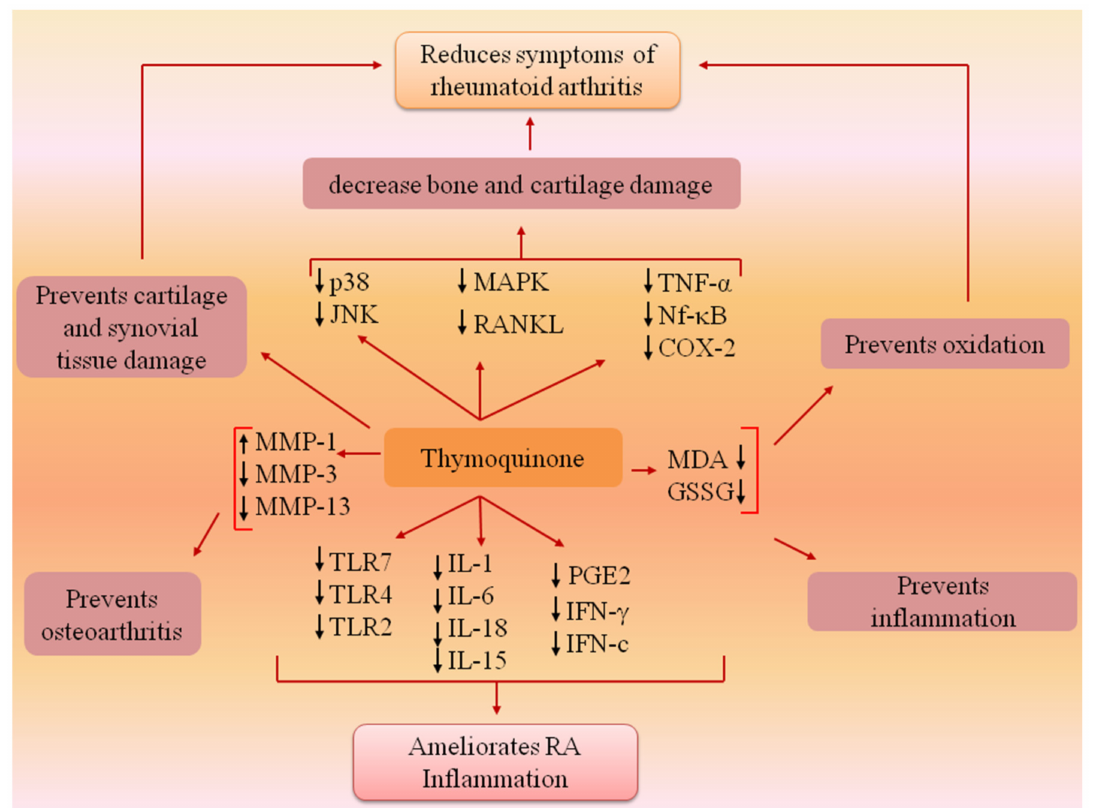
Figure 3. Anti-arthritic mechanism of TQ. TQ significantly downregulated the elevated levels of TLR-7, TLR-4, MMP-13, MMP-3, and other inflammatory cytokines, including TNF- α , IL-1 β , PGE2, and IL-6 and upregulated the expression of MMP- 1 to reduce arthritis scoring and bone leaching in arthritis. TLR—Toll-like receptor; IL—interleukin; PGE2—prostaglandin E2; MDA—malondialdehyde; GSSG—glutathione; MMP—matrix metalloproteinase; RANKL—receptor-activated nuclear factor kappa-B ligand; COX—cyclooxygenase-2; MAPK—mitogen-activated protein